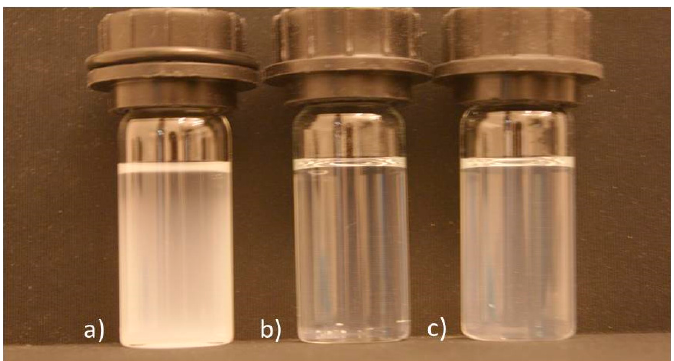
Figure 3. Cuvettes with exfoliated suspensions (after 4 h) of Mg 1 − x Al x (OH) 2 (NO 3 ) x · m H 2 O with x = ( a ) 0.20, ( b ) 0.25, ( c ) 0.33. A complete comparison of difference in end turbidity between suspensions of Mg-Al nitrate LDHs versus x is shown in Figure S3.